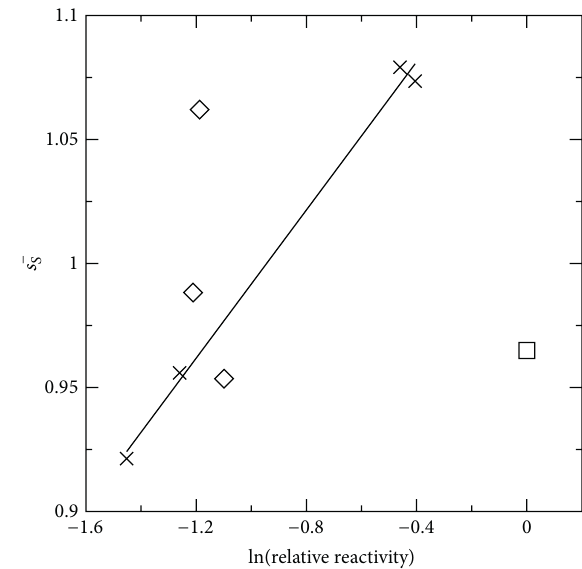
Figure 2: Dipole moment as a function of the position of the third methyl (C 𝑥 ) in trimethyldibenzothiophene and its corresponding dimethyldibenzothiophene (𝑥 = 0) . Crosses represent the series of molecules {𝑥 ,4,7-TMDBT, (𝑥 = 1, 2, 3)} , diamonds represent {𝑥 ,4,6- TMDBT, (𝑥 = 1, 2,3)} , squares represent {𝑥 ,3,7-TMDBT, (𝑥 = 1, 2)} , and circles represent {𝑥 ,3,6-TMDBT, (𝑥 = 1,2)} .